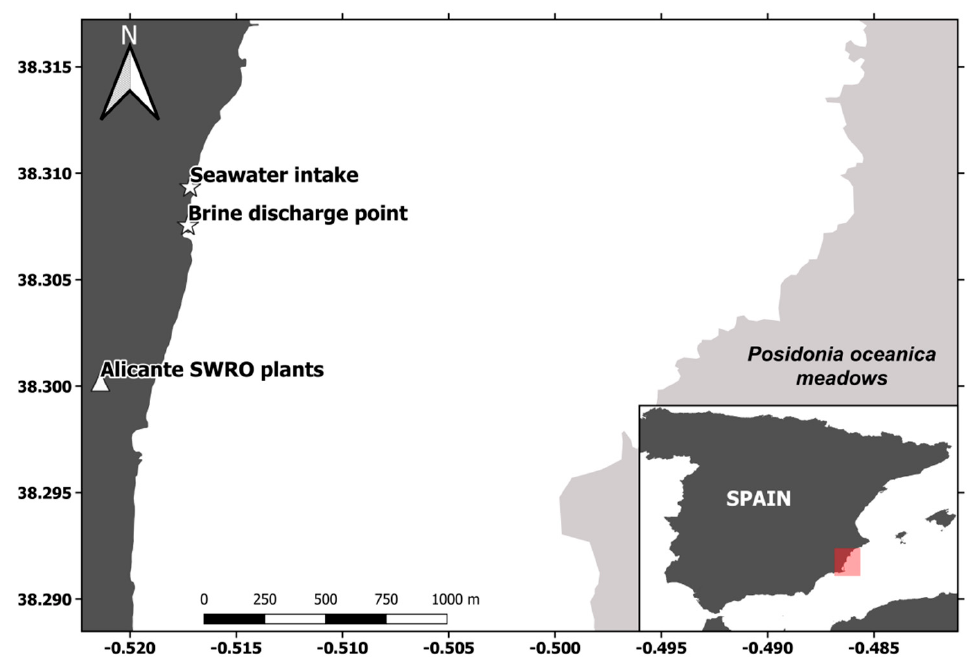
Figure 1. Location of the desalination plant, seawater intake for dilution, and diluted brine discharge point. The upper limit of the seagrass meadow is also indicated.